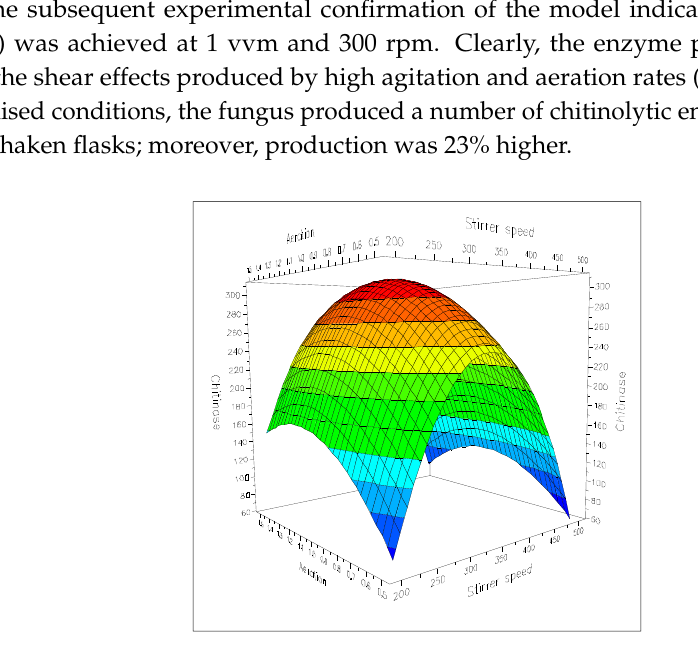
Figure 5. Combined effects of agitation and aeration on the chitinolytic activity of L. muscarium CCFEE 5003 cultivated in bioreactor as predicted by RSM. Colour codes in the surface response indicate different ranges of values (unpublished picture related to [46]).